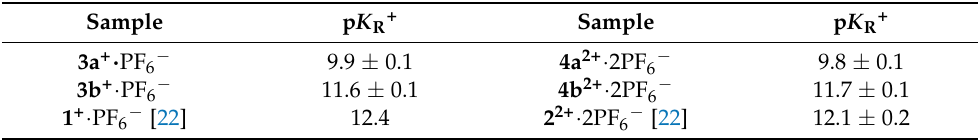
Table 2. p K R+ Values a of 3a , b + · PF 6 − , 4a , b 2+ · 2PF 6 − , 1 + · PF 6 − , and 2 2+ · 2PF 6 − .